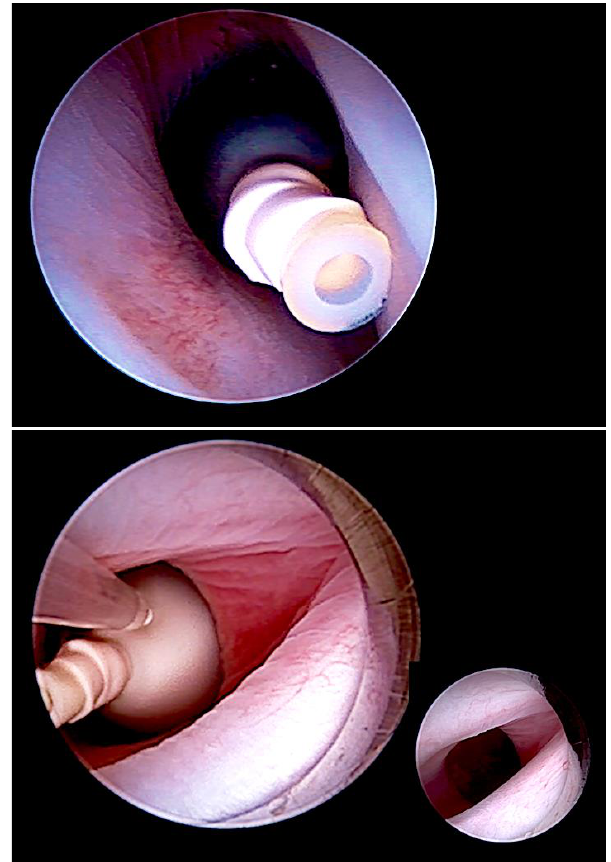
Figure 2. Minimally invasive, fully percutaneous fetoscopic tracheal balloon occlusion (FETO) ( top ) for the treatment of fetuses with severe pulmonary hypoplasia. FETO has most commonly been used in fetuses with diaphragmatic hernia. In addition, we observed it to be also particularly effective for the treatment of lungs compromised by long-standing anhydramnios following early preterm premature rupture of membranes prior to 20 weeks of gestation. It can also be applied to save fetuses with pulmonary hypoplasia from poorly distending and poorly perfused lungs after drainage of severe hydrothorax or after volume reduction of CPAMS. Following a period of one to several weeks, the balloon is removed by a second intervention ( bottom ).